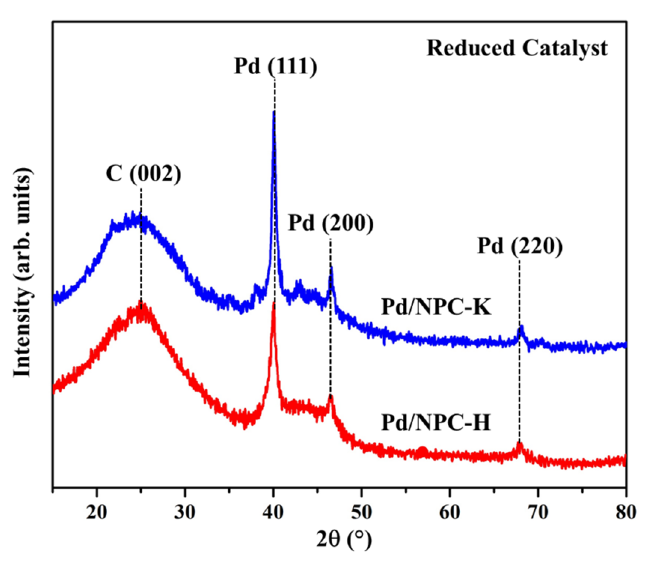
Figure 6. XRD patterns of the reduced Pd/NPC-K (blue curves) and Pd/NPC-H (red curves) catalysts. The TEM images of the reduced Pd/NPC-K catalyst showed coexisting large Pd particles in the 10–13 nm size range. The smaller Pd particles in a size range of 6–8 nm were observed in the reduced Pd/NPC-H catalyst (Figure 7a,b, respectively). The Pd crystalline size from the XRD results is in accordance with the Pd particle size in the TEM image of both catalysts, as seen in Table 4. Dissolving the Pd(NO 3 ) 2 precursor in deionized water re- sulted in an aqueous solution of [Pd(H 2 O) 4 ] 2+ cations with a pH range of 1.57–1.60. On Pd NPC surface took place under acidic conditions. The large Pd particle and low Pd disper-